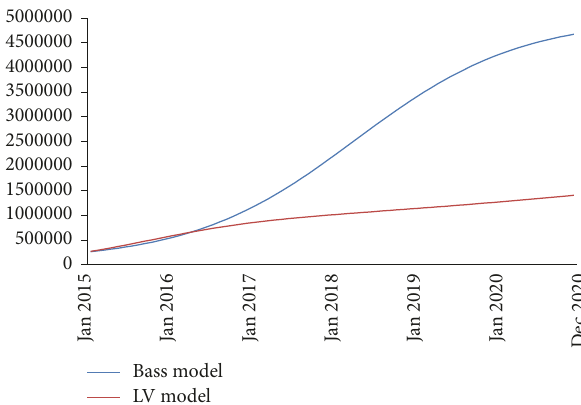
Figure 1: Forecasting of BEV ownership from 2017 to 2020 based on the two